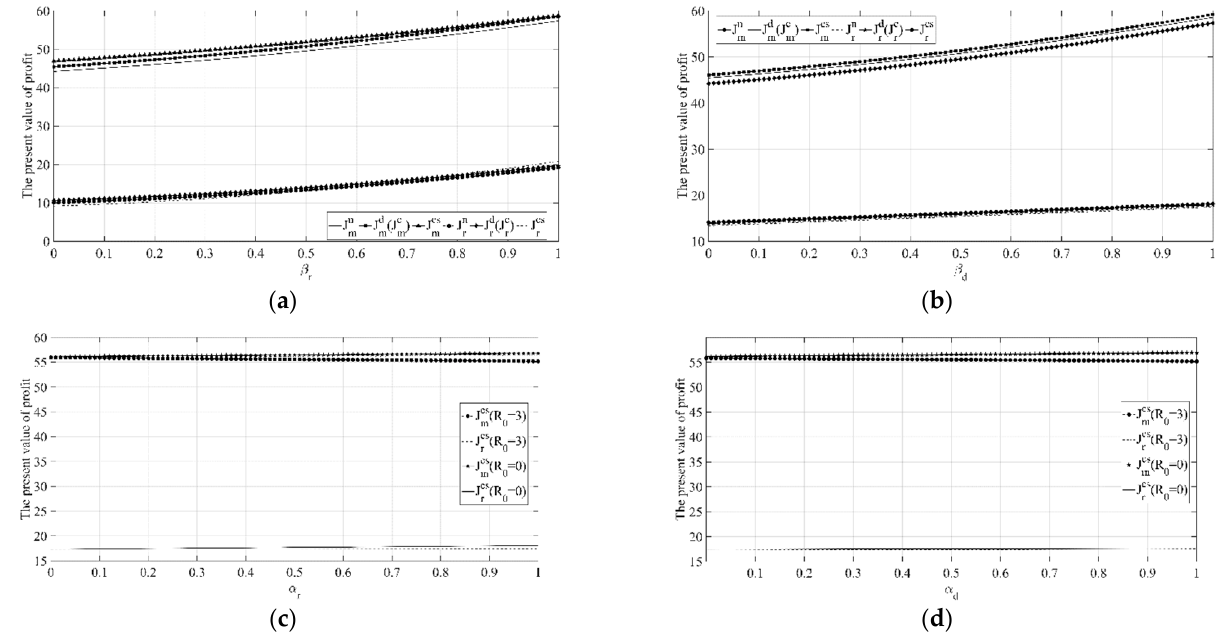
Figure 7. The impact of effectiveness parameters on profits. ( a ) The effect of β r on profits. ( b ) The effect of β d on profits. ( c ) The effect of α r on profits. ( d ) The effect of α d on profits.